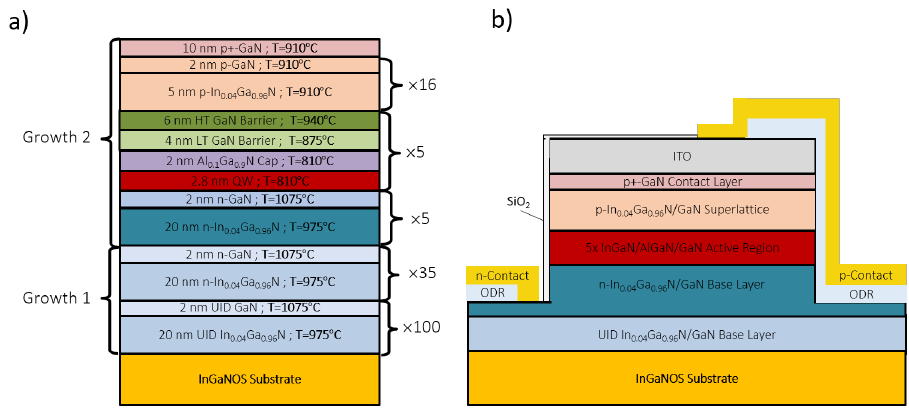
Figure 1. ( a ) Cross-section of device epilayer structure with layer temperatures indicated. ( b ) Cross- sectional schematic of finished fabricated